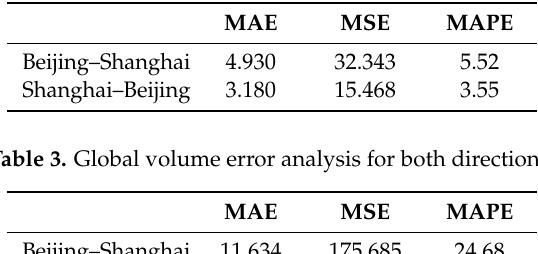
Table 2. Global speed error analysis for both directions.